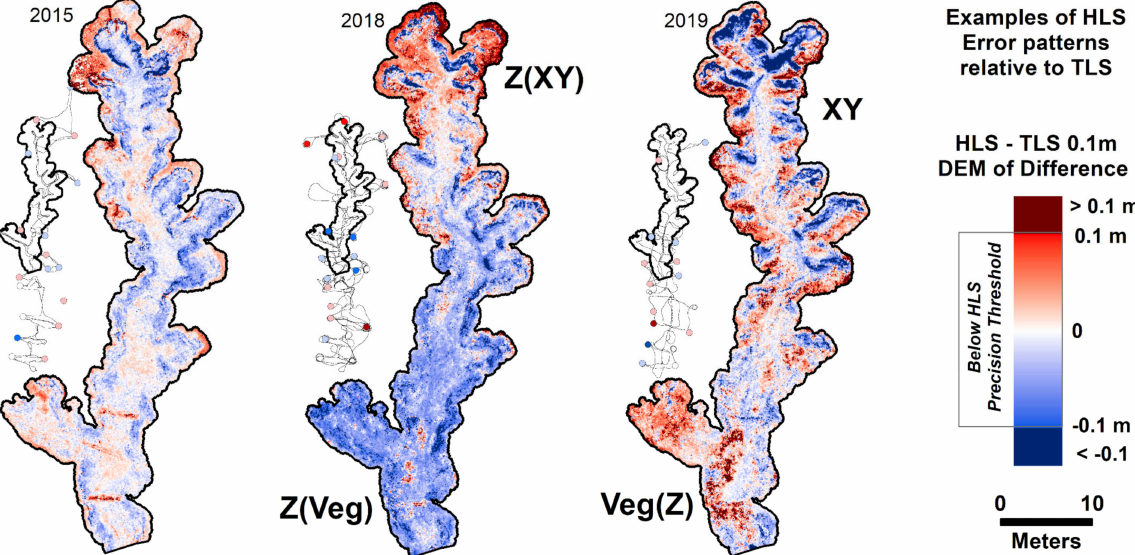
Figure 6. Examples of spatial patterns of error in HLS as observed in HLS-TLS DEMs of Difference for 3 selected dates. Uphill direction and headcut is towards the top of figure. Downstream direction is towards the bottom of figure. Insets show the DoD extents relative to the full HLS trajectory path and survey markers for that date. Survey markers are coloured by the Z residuals of the transforms (A in Figure 4) using same colour scheme as DoD. Contributing factor or factors (lesser one in brackets) to HLS-TLS DoD error patterns are labelled next to examples: XY = offsets in XY between HLS and TLS, Z = offsets in Z between HLS and TLS, Veg = vegetation artefacts. (See descriptions in text). The year 2015 is an example of a scan that matches well with TLS, except for minor XYZ offsets near the headcut, and minor Veg artefacts (red artefacts at downstream end of survey are porous check dams made of sticks). Generally errors are within the precision threshold for HLS, with dark red and blue exceeding